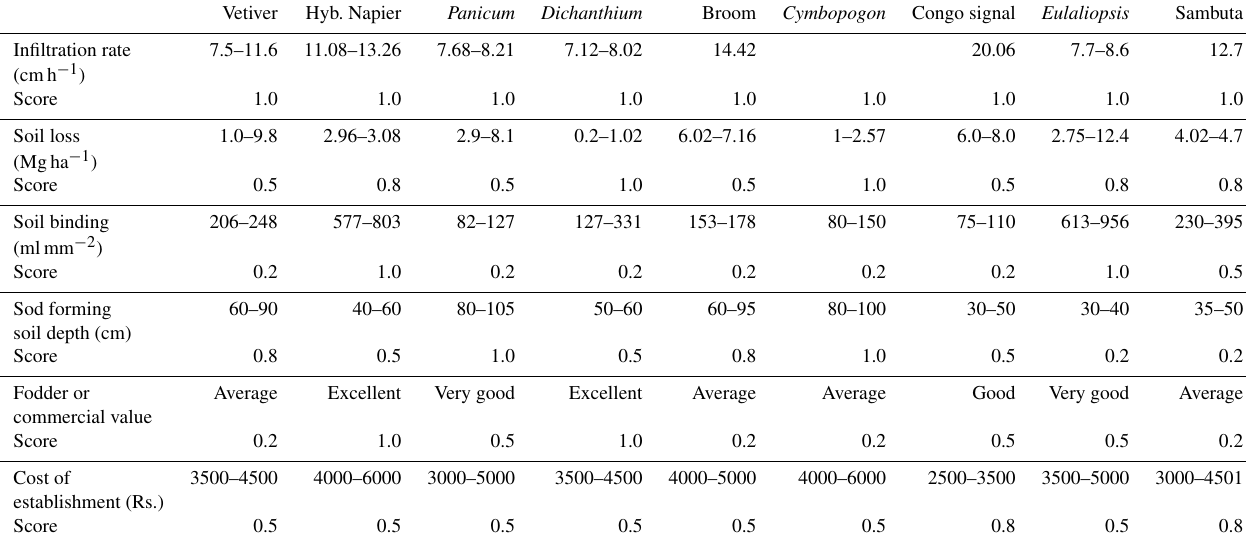
Table 2. Various attributes and normalized scores used for calculating CPI for different vegetative